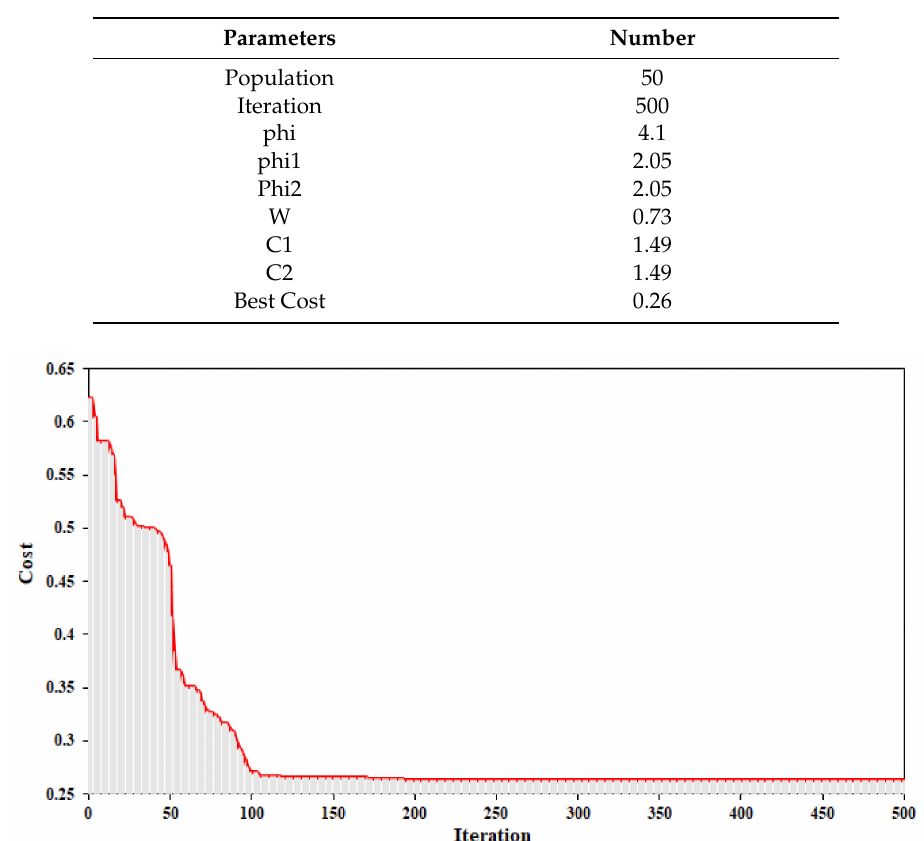
Table 7. Parameters used in PSO algorithms in combined DLNN.